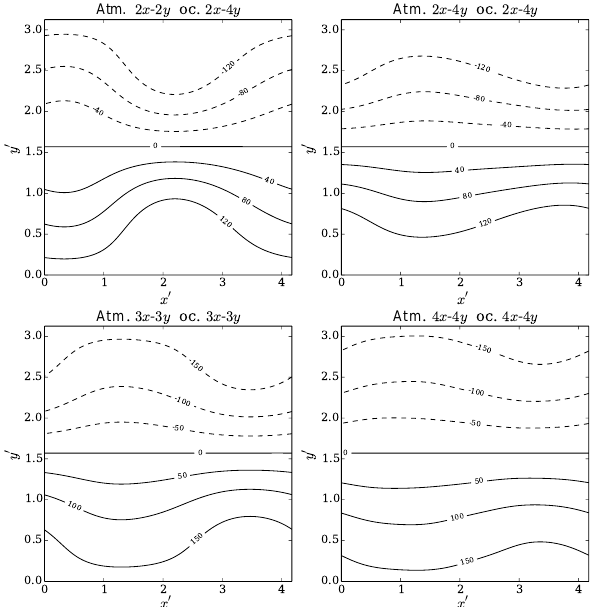
Figure 9. Climatologies for the geopotential height field z = f 0 (m) presented on the non-dimensional model domain, as obtained using 92179.6 years of model